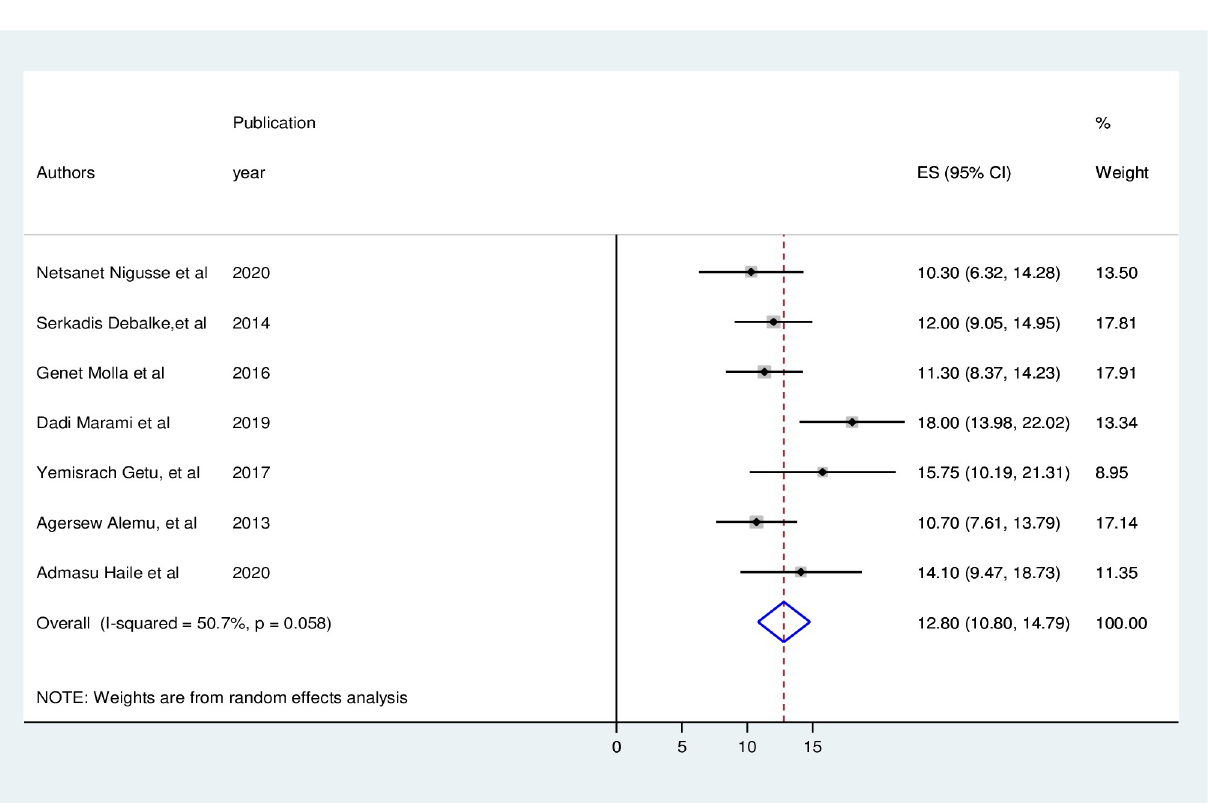
Fig 2. The pooled prevalence of urinary tract infection among people living with HIV in Ethiopia.